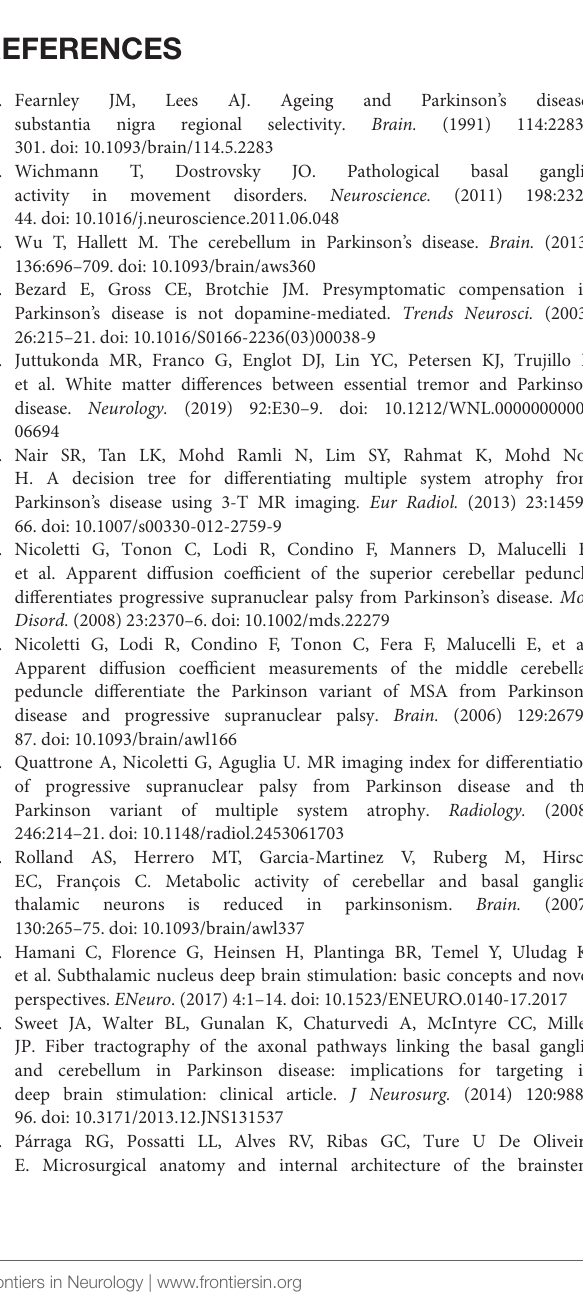
Supplementary Figure S5 | Reconstruction of the inferior cerebellar peduncle (ICP). The figure shows the first AND region (A) , second AND region (B) , the three retained NOT regions along with a reconstructed ICP tract in a color-coded fiber orientation image (C) and the reconstructed ICP in a T1 anatomical image (D) in an example dataset. Red NOT regions, ROI 1 and ROI 2, were drawn above and in front of the fornix and final ROI 3 at the longitudinal fissure. Supplementary Figure S6 | Reconstructed full and segmented DRTT and SPCT. The reconstructed DRTT with its cortical projections is shown in (A) and the segmented DRTT is shown in (B) along with the ROIs at the level of the thalamus and the dentate nucleus. The fully reconstructed SPCT with its cortical connections is shown in (C) and the segmented SPCT is shown in (D) along with the ROI at the level of the subthalamic nucleus. Supplementary Table 1 | Inter-operator reliability. Spatial dice coefficients across the tracts that were independently segmented by two operators are reported in column 1. Statistical comparison (paired t -test) between the size of the